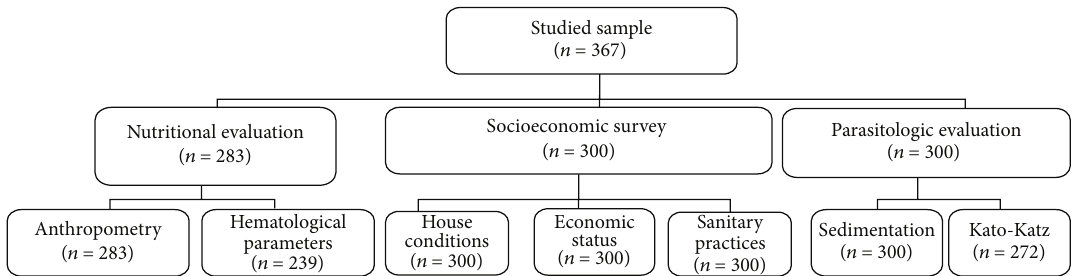
Figure 1: Flow chart of the number of participants included in each evaluation of the study.